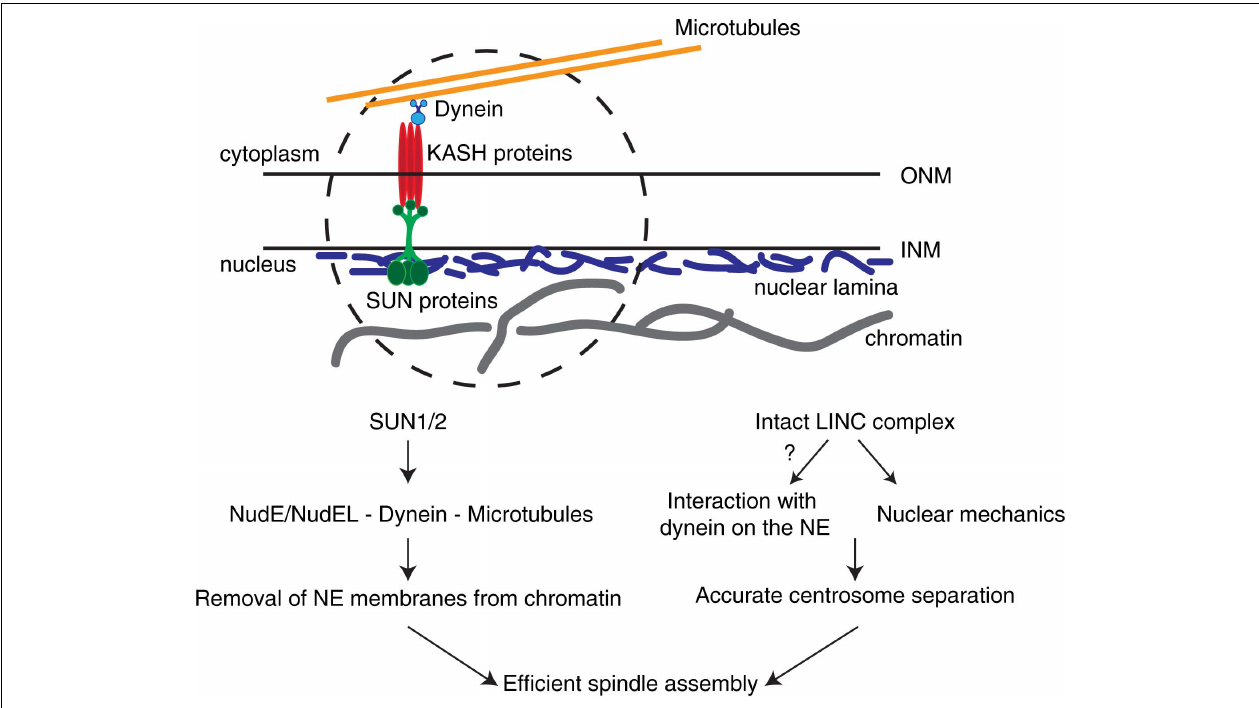
FIGURE 2 | The LINC complex in early spindle assembly and chromosome segregation. The LINC complex consists of SUN1/2 trimers on the inner nuclear membrane (INM) and KASH proteins on the outer nuclear membrane (ONM). In somatic cells, different KASH proteins differentially bind to specific motors (e.g., dynein) or to distinct cytoskeletal components. These complexes are able to sense forces relayed by the cytoskeleton and transmit them to the nuclear interior. During the G2-M transition, SUN proteins are required to remove NE membranes from chromatin and position centrosomes. In addition, an intact LINC complex is necessary for correct centrosome separation. Whether this is due to LINC complex-dependent loading of dynein on the NE or to nuclear mechanotransduction remains